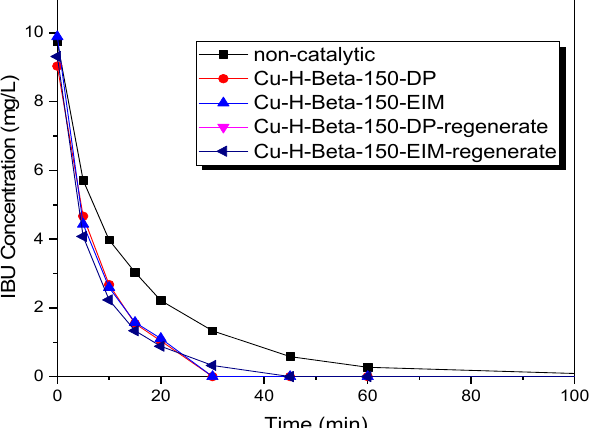
Figure 8. The degradation of IBU via catalytic ozonation in the presence of 2.5 mL/min nitrogen. [IBU] = 10 mg/L, gas flow rate = 452.5 mL/min, T = 20 °C, stirring rate = 1070 rpm.